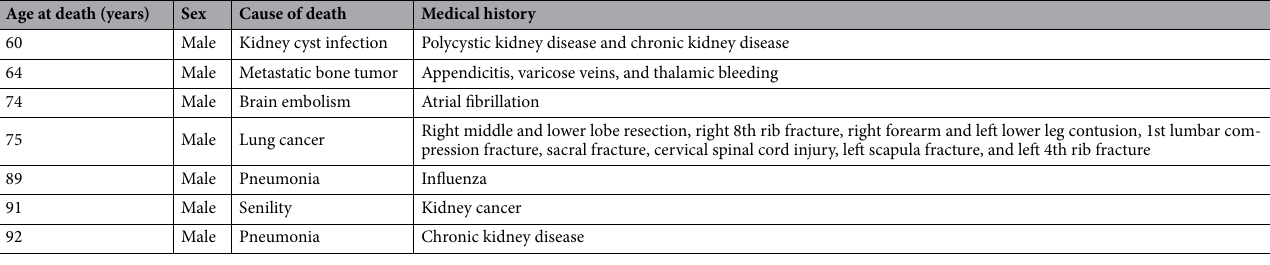
Table 1. Details of body